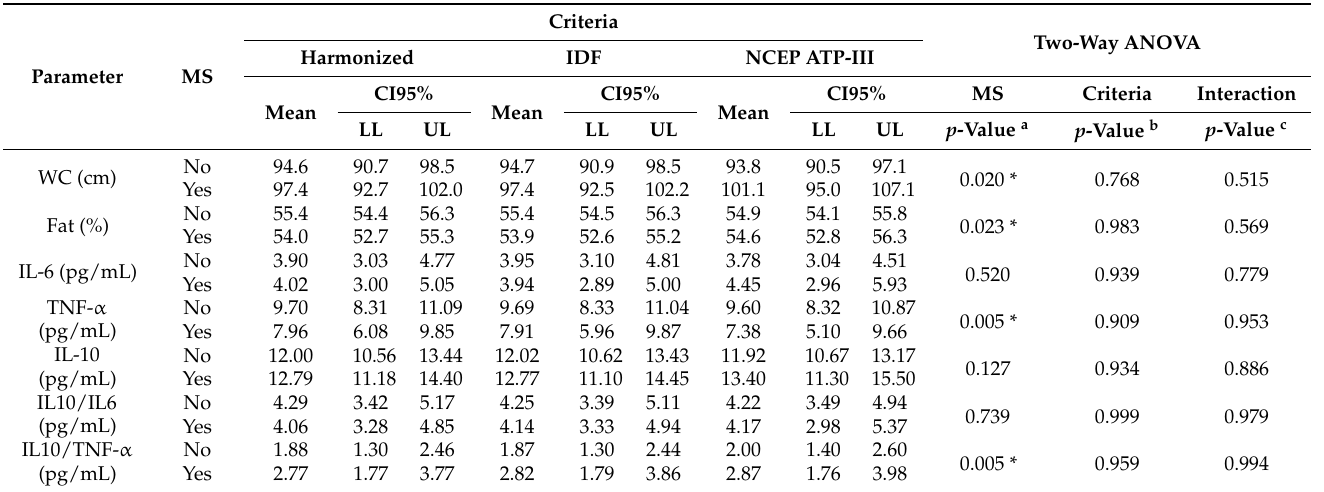
Table 4. Comparison of mean 95% confidence intervals (95%CI) of waist circumference (cm), body fat (%), and inflammatory markers between subjects with and without metabolic syndrome (MS) for the three diagnostic